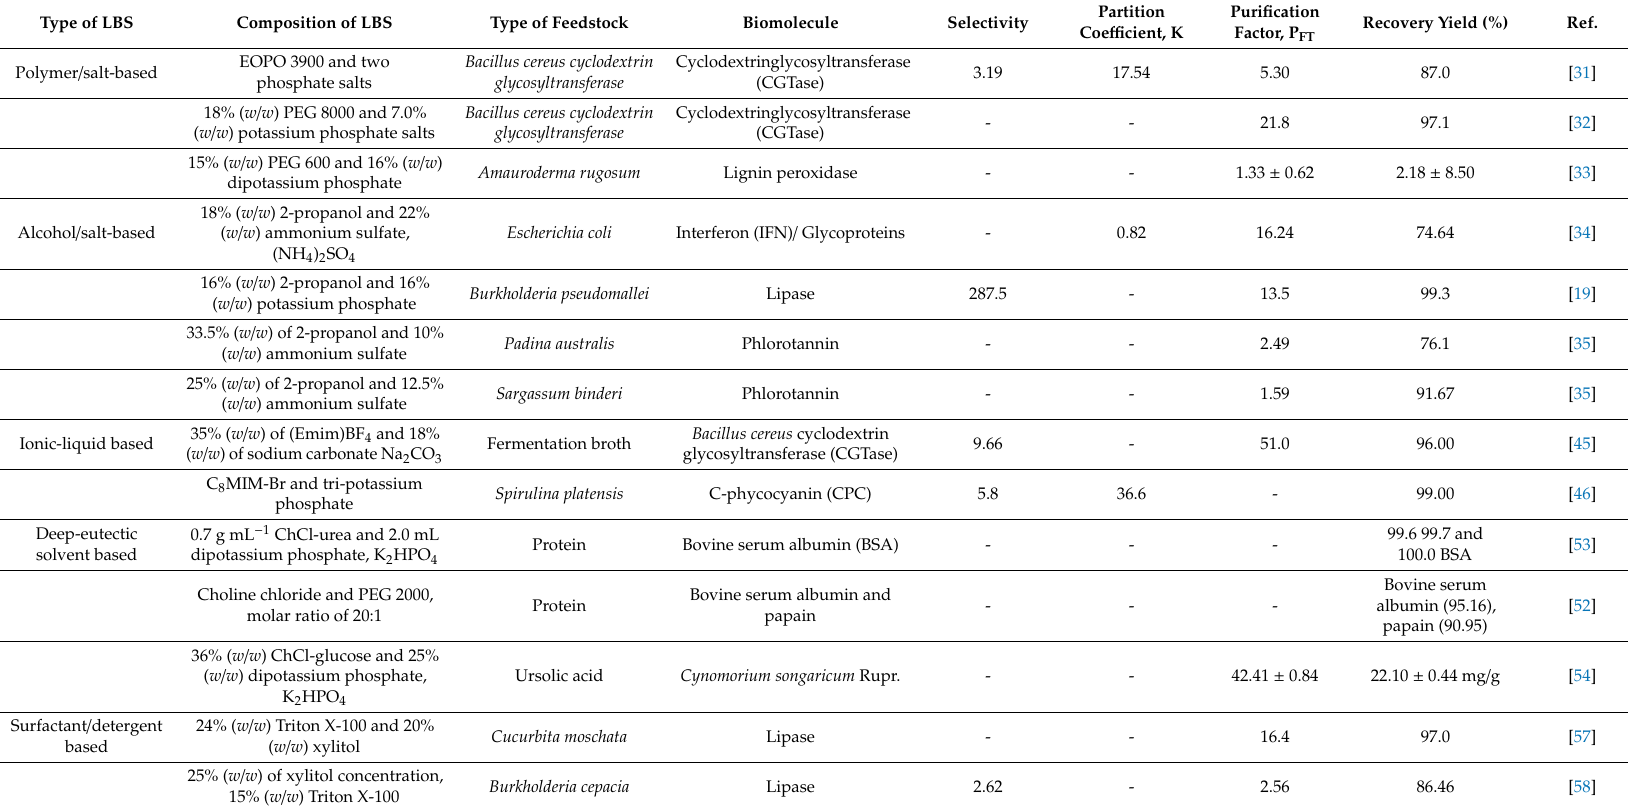
Table 1. Extraction of biomolecules using various types of phase-forming components in